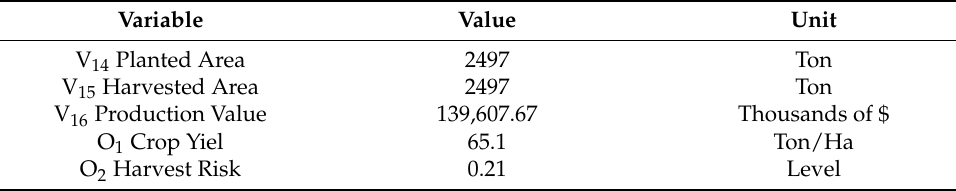
Table A7. Fuzzy model input parameters: crop vulnerability.